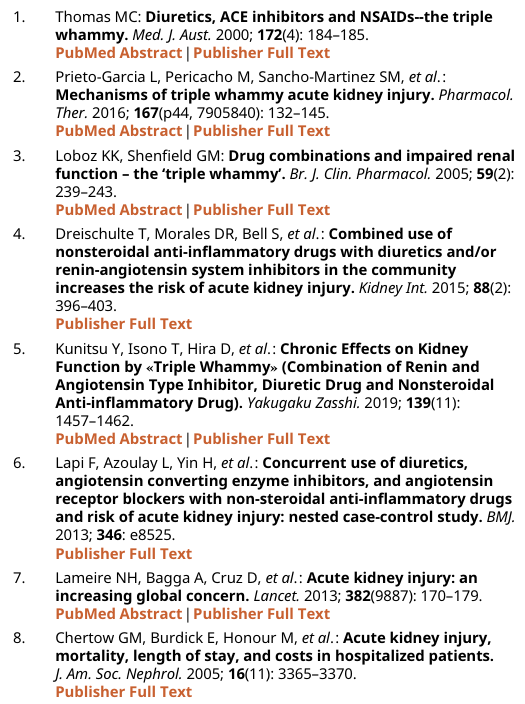
Figshare: PRISMA-P checklist for ‘ Acute Kidney Injury associated with “ Triple whammy ” combination: a protocol for a systematic review ’